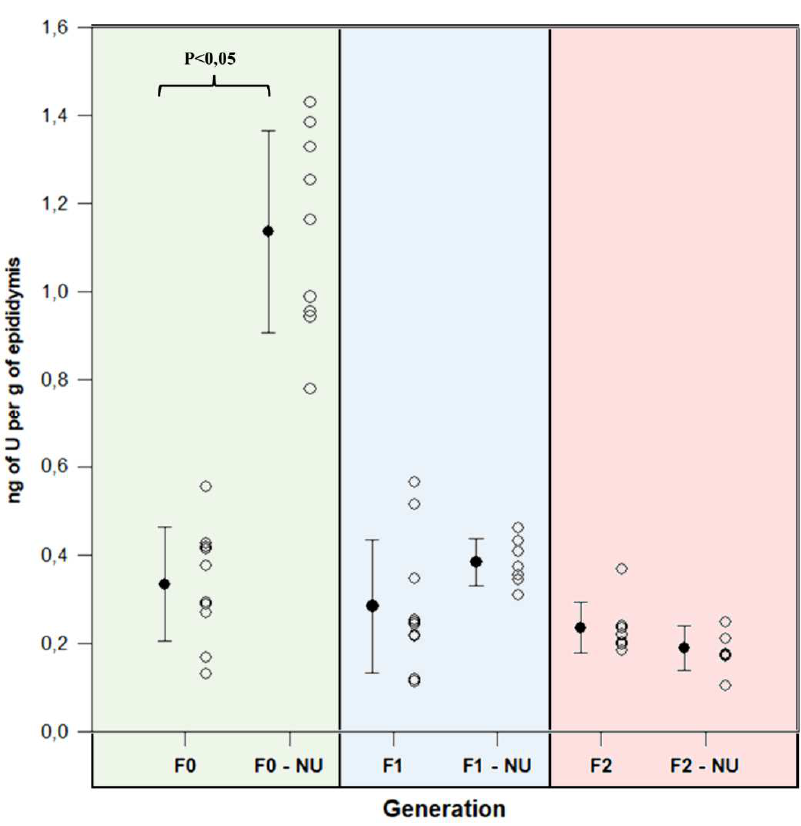
Figure 2. Quantification of uranium in the epididymis for each generation. Significant effects are defined as p < 0.05; n = 7–10 per group.